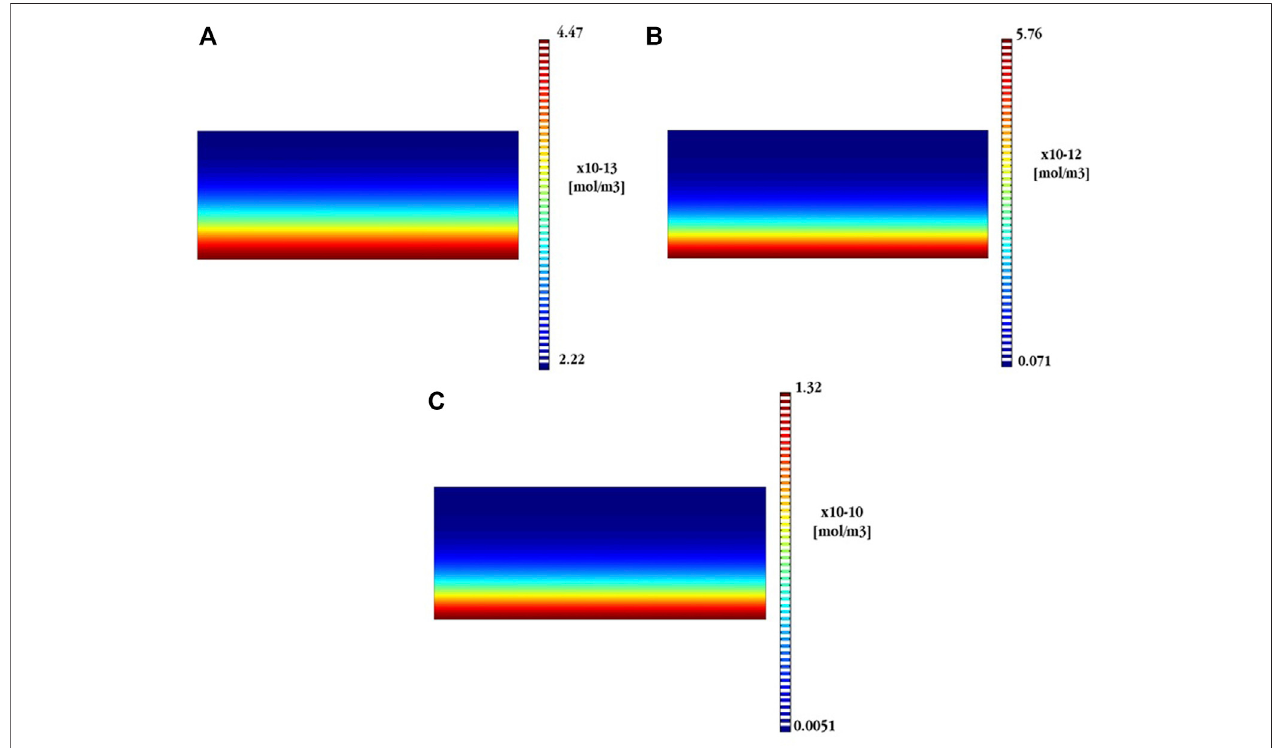
FIGURE 9 | Numerical predictions, into the electrolyte, of the formation of (A) ZnO (in 3%Cl (cid:1) ), (B) CaZn 2 (OH) 6 (in 3%Cl (cid:1) ), and (C) CaZn 2 (OH) 6 (in 0.03%Cl (cid:1) ).